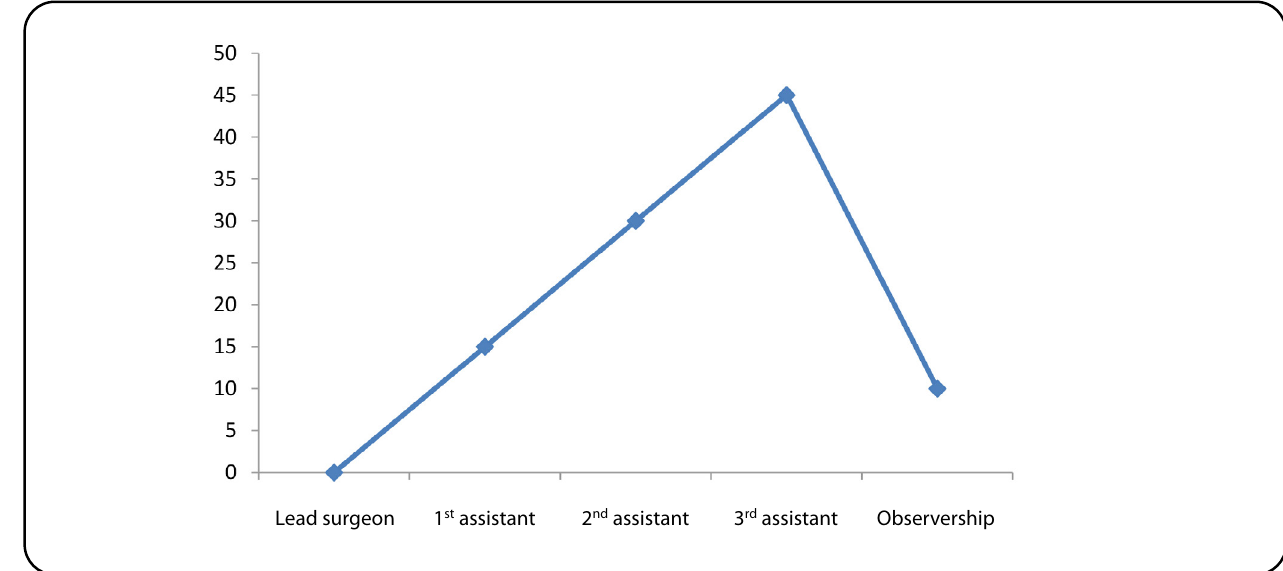
Fig. 1 - Level of participation of local surgeons.